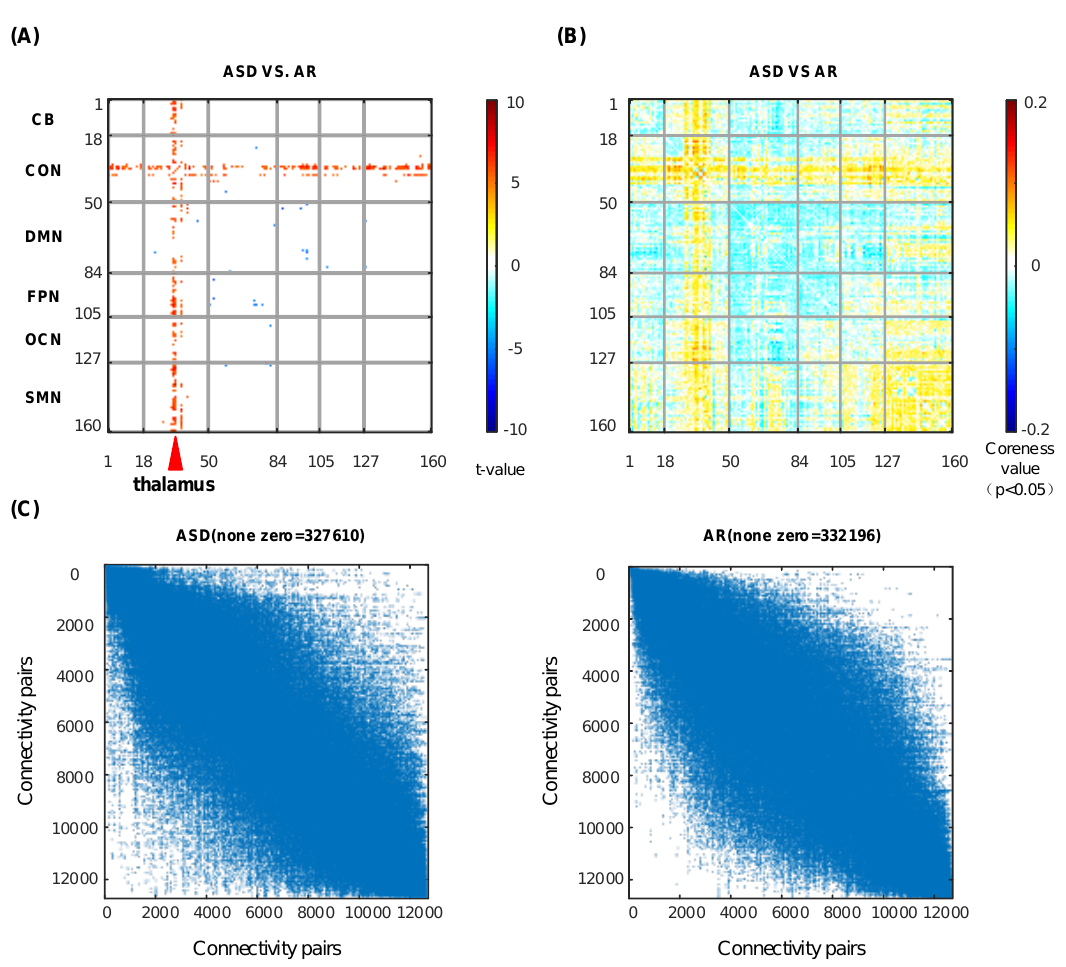
Figure 5. The two-sample t -test and permutation test for the ASD and AR states. ( A ) The two-sample t -test ( p < 0.05 and FWER q < 0.05 ) discrimination maps for ASD and AR states. ( B ) The permutation test discriminative coreness value map under p < 0.05. ( C ) The adjacency matrix for ASD and AR groups. The non-zero values of the matrix are tagged on the top of the